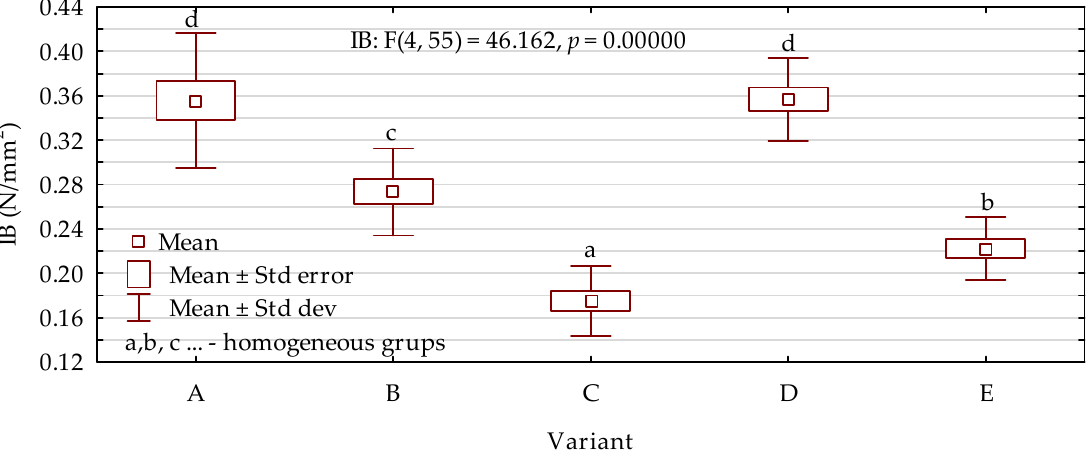
Figure 7. Internal bonding results depending on the board variant (letters A–E mark variants of the boards).